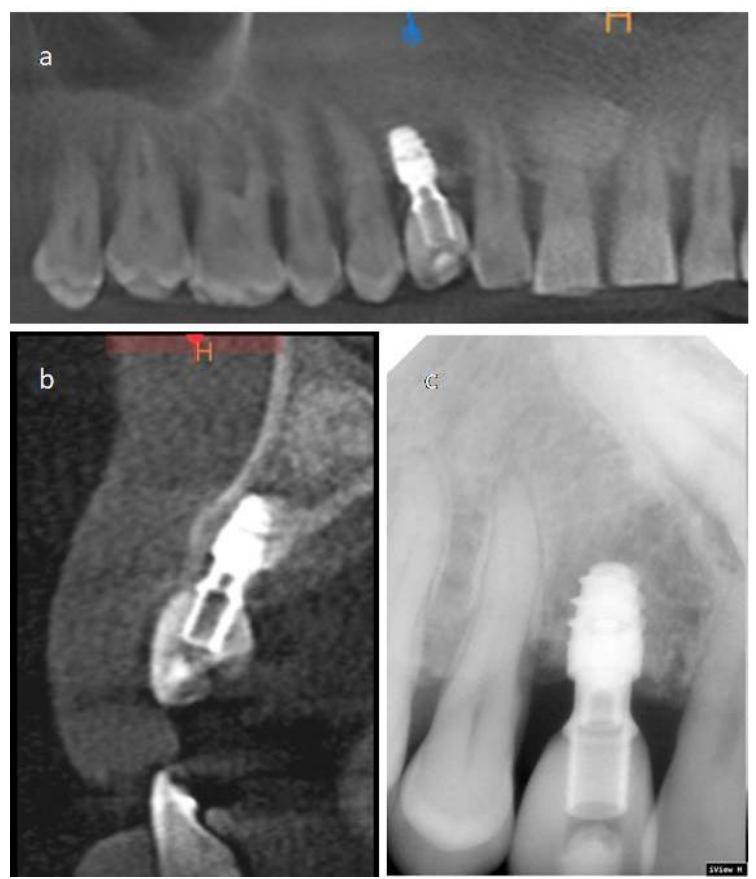
Figure 5. Case 1 last follow-up (3 years after the surgery). ( a ) CT-Scan image analogous to panoramic radiography of the first quadrant. ( b ) Sagittal section shows the dental implant. ( c ) Periapical radiograph.